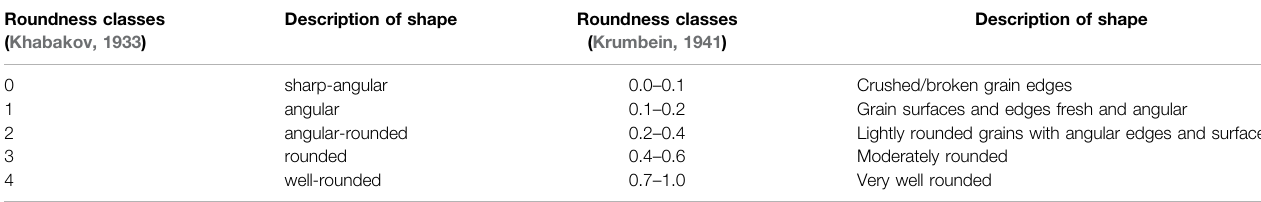
TABLE 1 | Classi fi cation of grain roundness according to Khabakov (1933) and according to Krumbein (1941). Roundness classes (Khabakov,